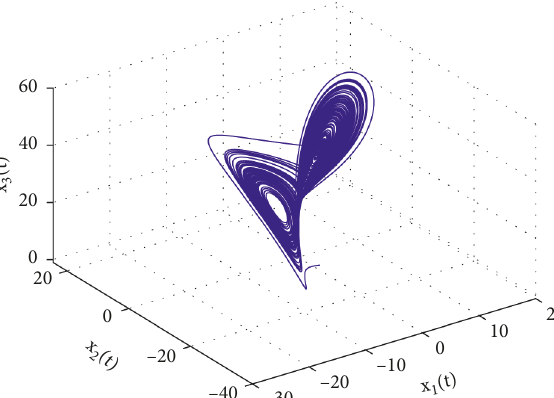
Figure 2: Curve of (77) with x ( 0 ) � [ 2 , − 6 , − 2 ] T for mode 2.